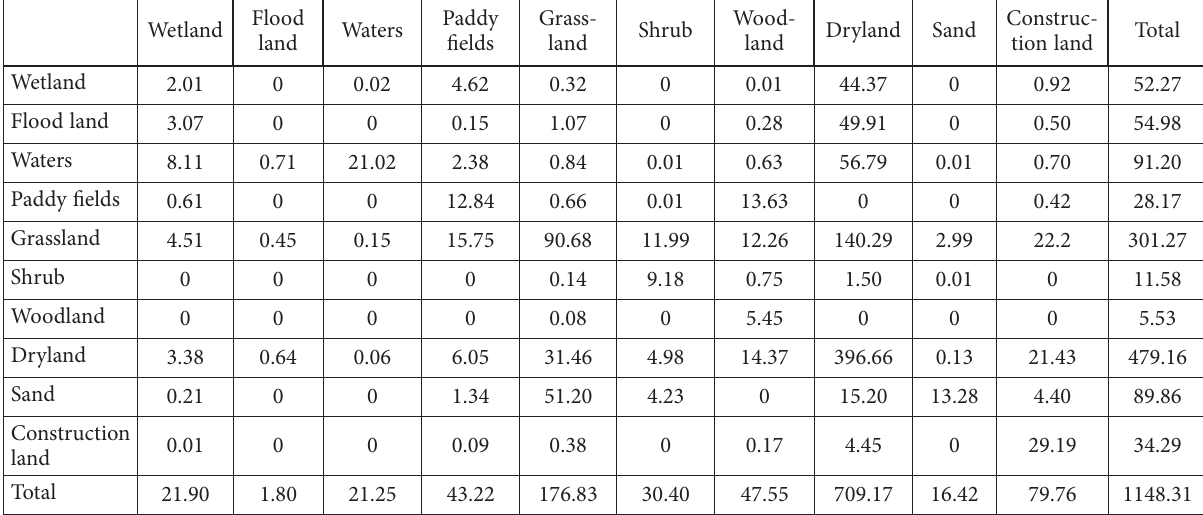
Table 4. Area transfer matrix of Hongshan Reservoir land use from 1985 to 2015 (km 2 ) Wetland